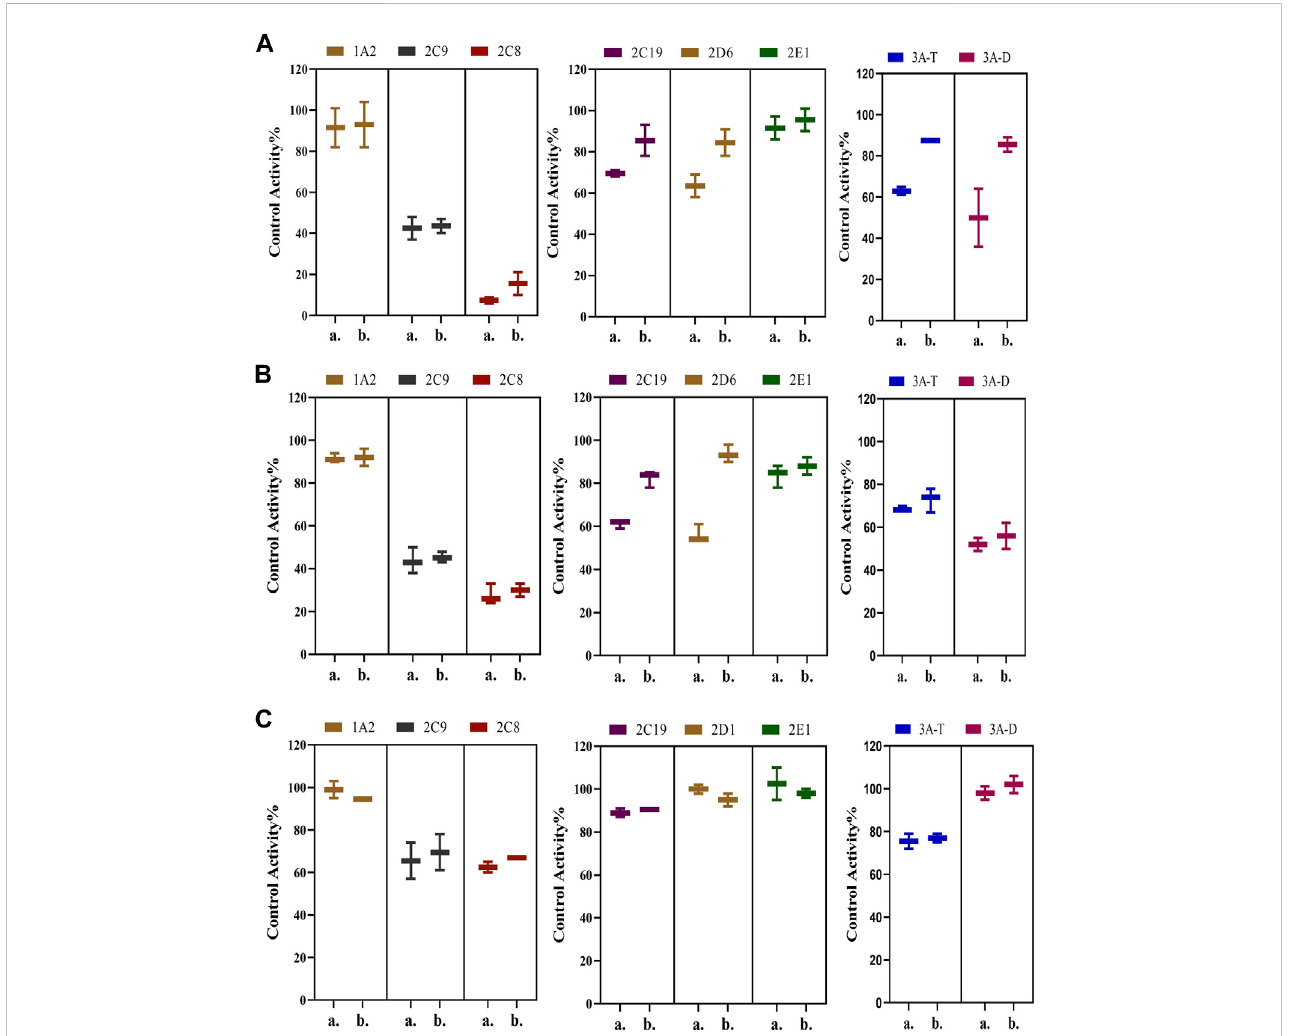
FIGURE 6 Percentage reduction in activity of seven enzymes after incubation with SDEA (A) , Amento fl avone (B) and Delica fl avone (C) using a single point time- dependent inhibition screening assay. The experiment was carried out three times. Note: (1) a. presence of NADPH; b. without NADPH. (2) 3A-T, CYP3A (Testosterone); 3A-D, CYP3A